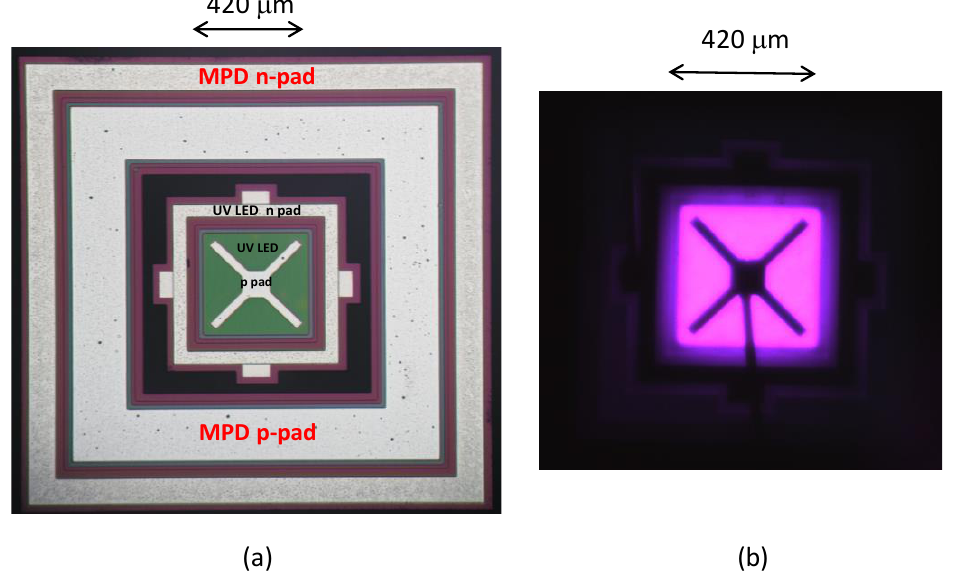
Figure 2. ( a ) A top-view photo of the fabricated UV LED and MPD; ( b ) an image of the UV LED at 10 mA in the dark.